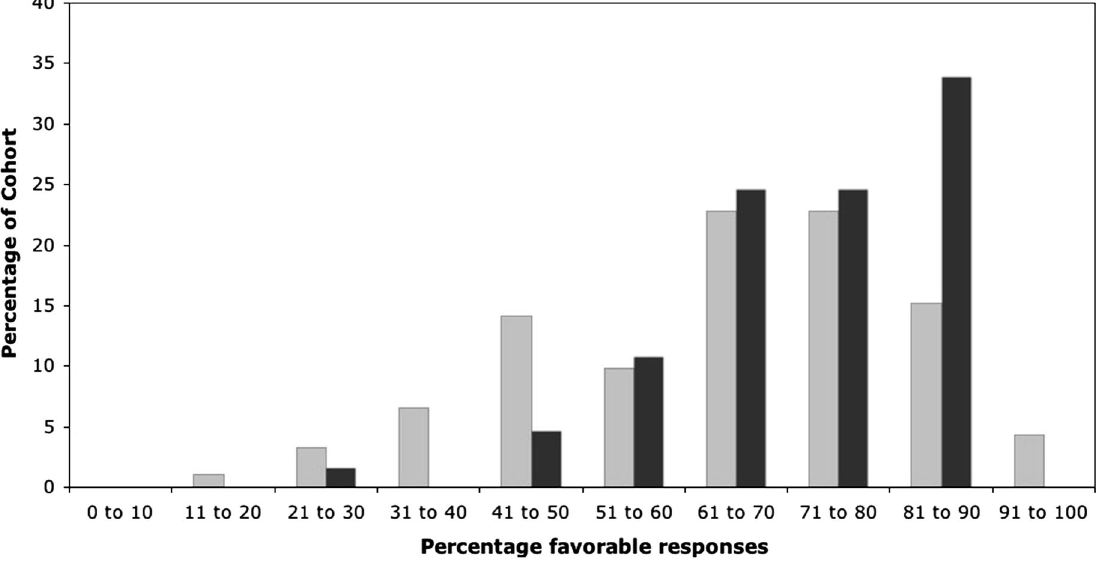
FIG. 2. Frequency of CLASS favorable scores for school (light gray bars, N ¼ 92 ) and intending (dark gray bars, N ¼ 65 )